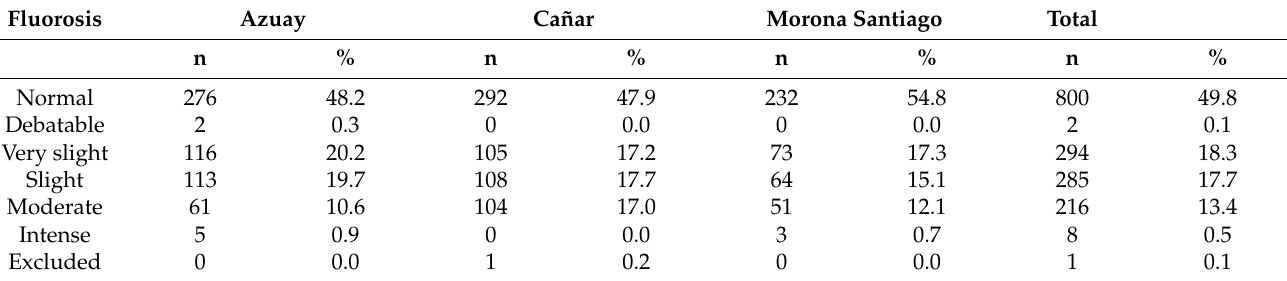
Table 1. Distribution of the Severity of DF by